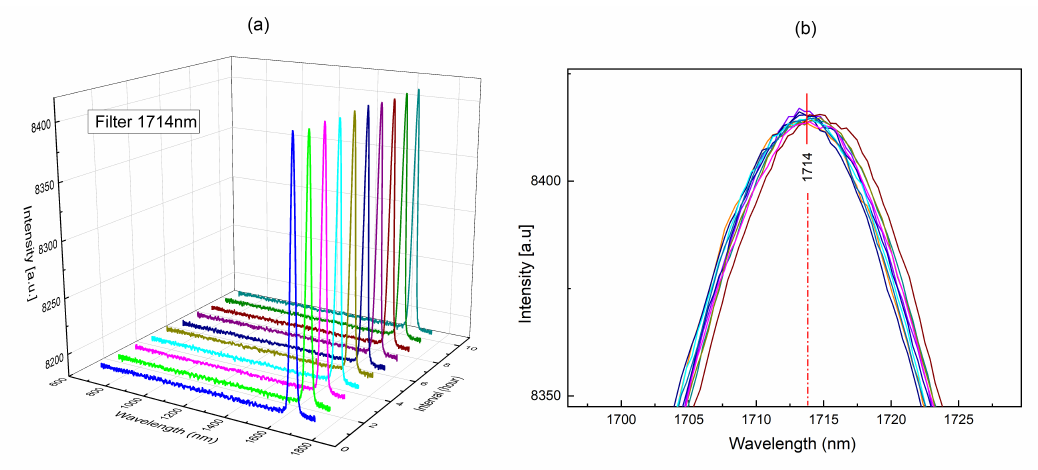
Figure 5. ( a ) Three-dimensional schematic of stability testing; ( b ) 10 measurements around the central wavelength of a 1714-nm filter.